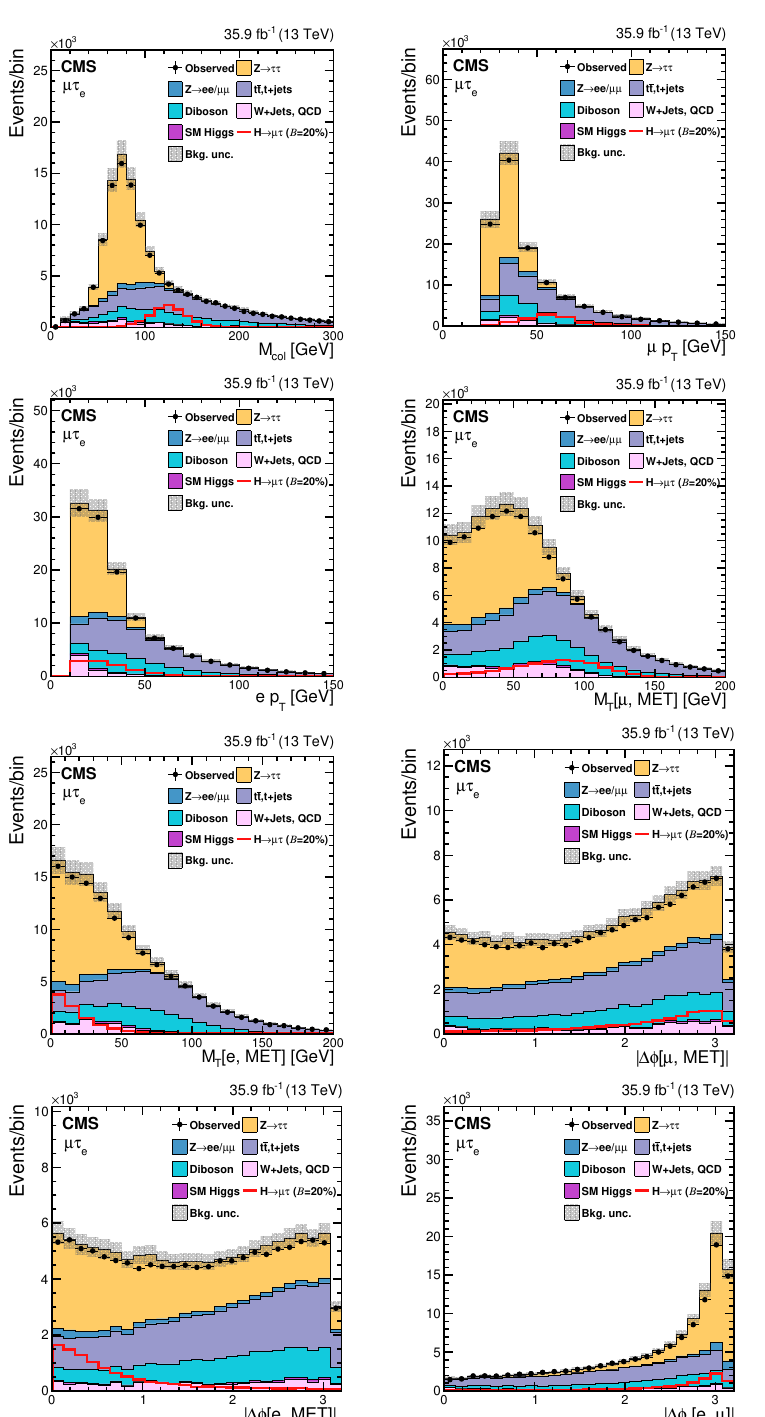
Figure 2 . Distributions of the input variables to the BDT for the H ! (cid:22)(cid:28) e channel.